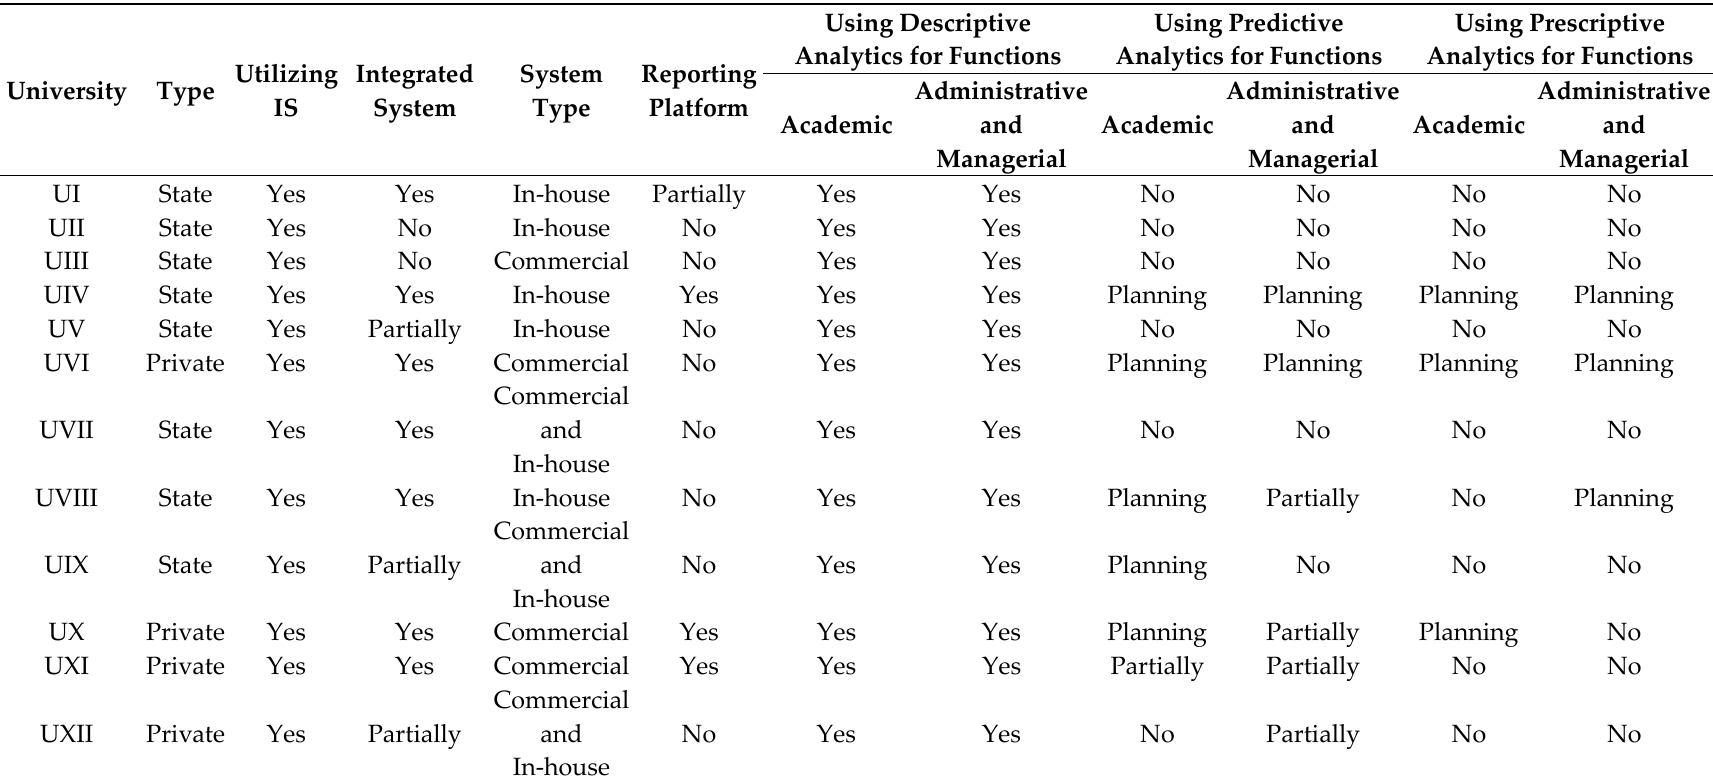
Table 3. Comparison of universities where case studies were